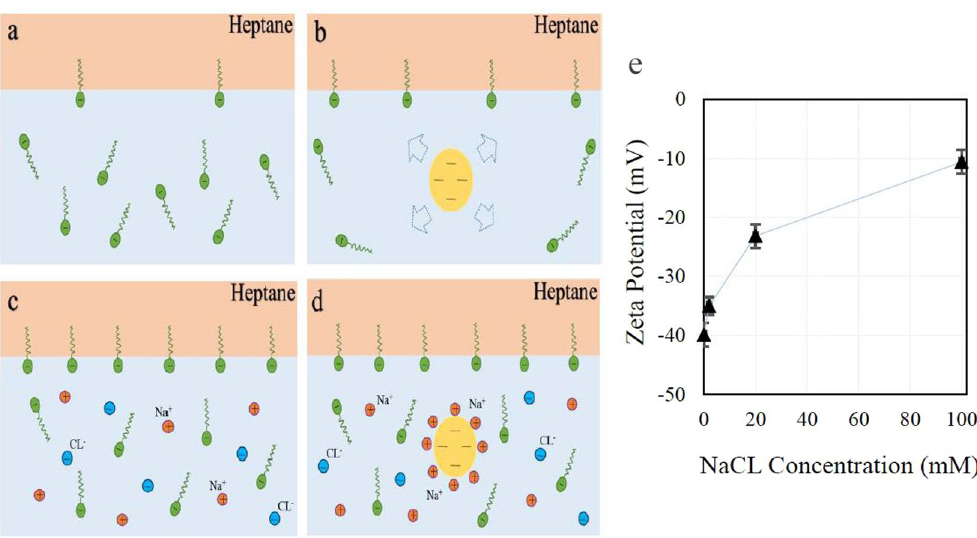
Figure 6. ( a – d ) Schematic presentation of the impact of the repulsive interaction between nanoparticles and surfactants to enhance the surfactant’s surface activity. ( a , b ) without salt, ( c , d ) in the presence of NaCl. ( e ) Variation of zeta potential of 2 wt.% nanofluid (Levasil 100/45, 30 nm) with the concentration of NaCL. The line is drawn as guide for the